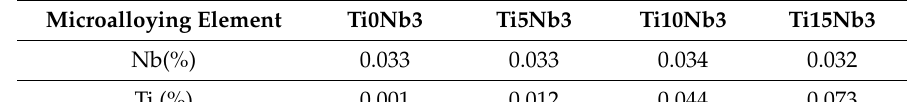
Table 4. Amount of Nb, Ti in solid solution in austenite (wt.%) at 1250 °C for the microalloyed steels calculated using Thermo-Calc software [34,35].